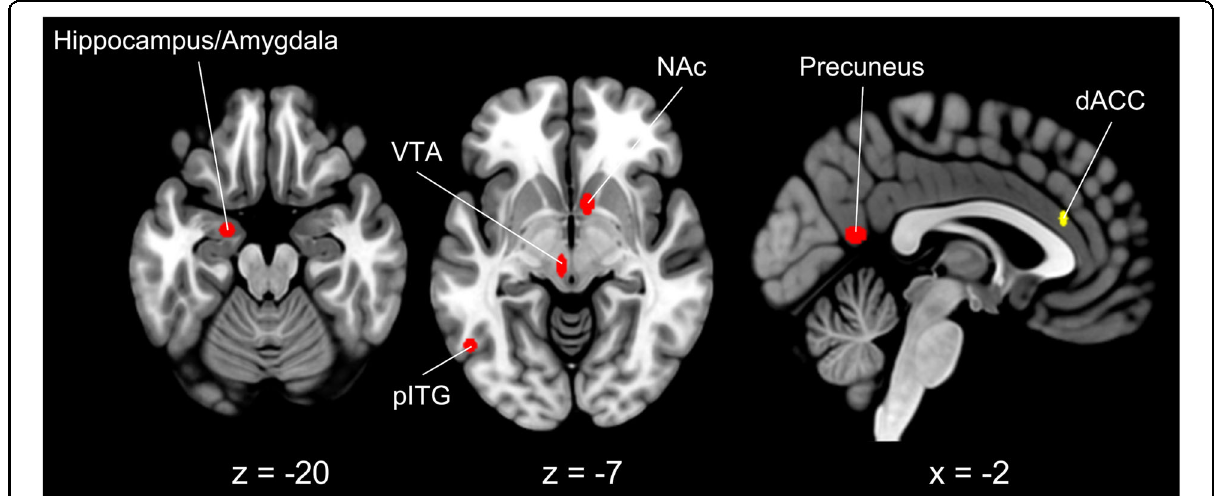
Fig. 1 Results of the binomial CCA for the factor “ class of substances ” . Clusters more frequently activated by individuals addicted to legal substances are depicted in yellow, whereas clusters more frequently activated by individuals addicted to illegal substances are depicted in red. Slice coordinates are reported in MNI stereotaxic space. The decoder function of Neurosynth returned the following 15 terms with the highest association with the CCA map (decreasing order): tools, motivational, anticipation, addiction, reward anticipation, outcome, subjective, behavior, monetary reward, complex, probabilistic, objects, incentive delay, form, sighted. dACC dorsal anterior cingulate cortex, pITG posterior inferior temporal gyrus, VTA ventral tegmental area.